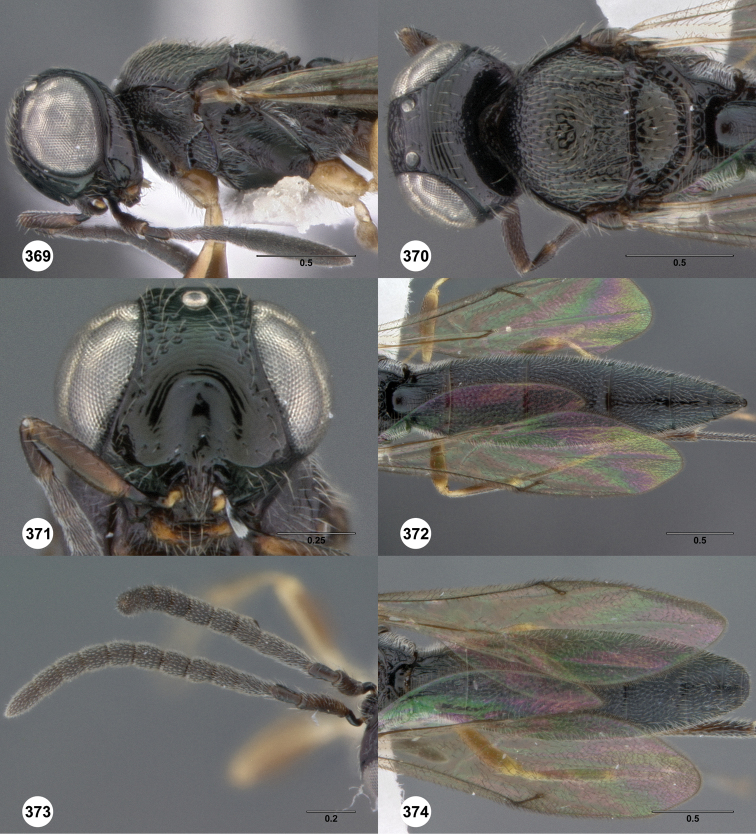
Oxyscelio tubi sp. n., holotype female (OSUC 225607) 369 Head and mesosoma, lateral view 370 Head and mesosoma, dorsal view 371 Head, anterior view 372 Metasoma, dorsal view. Paratype male (OSUC 221668) 373 Antenna. Paratype male (OSUC 221669) 374 Metasoma, dorsal view. Morphbank98